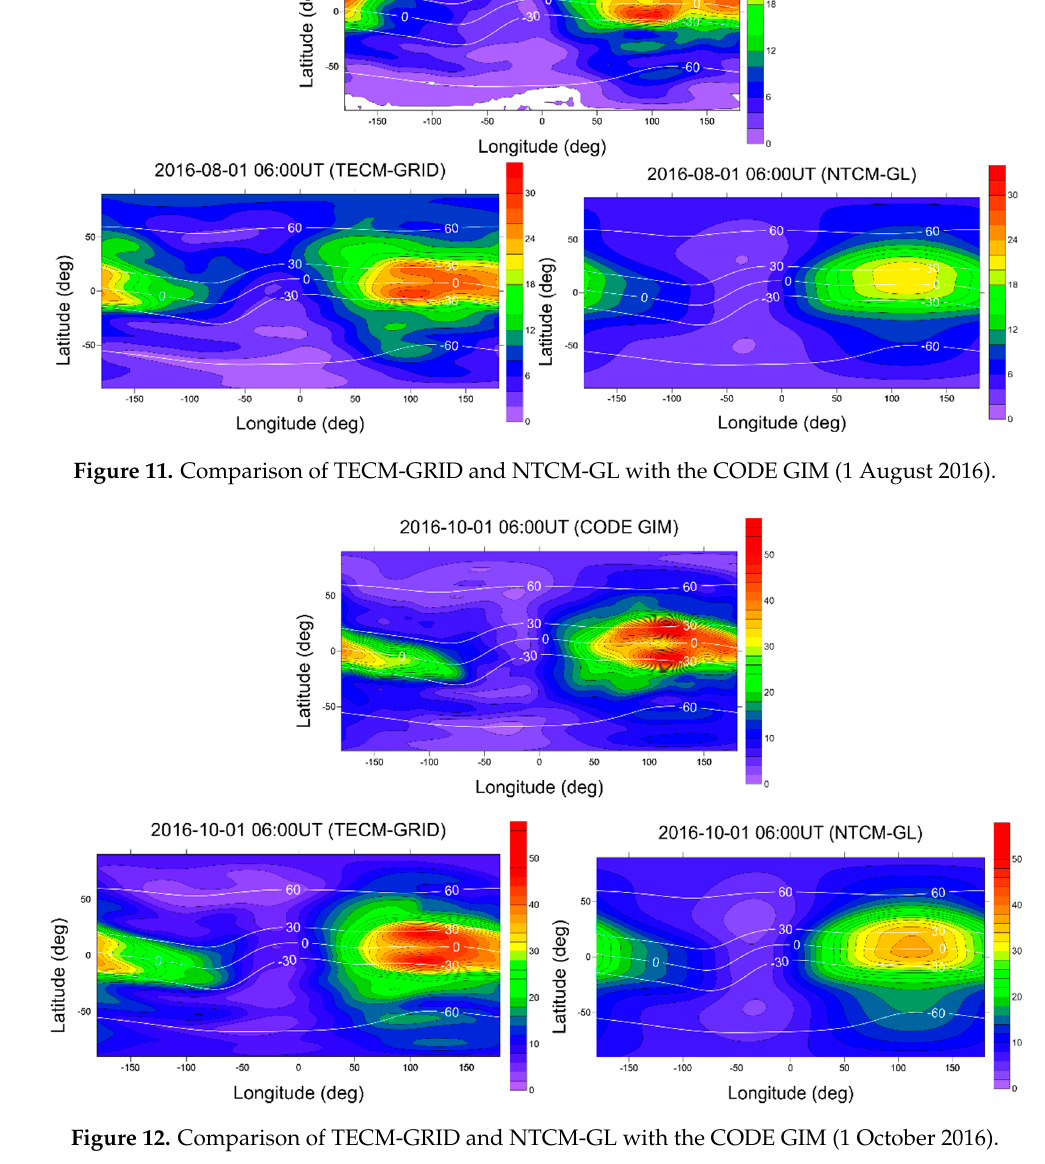
Figure 12. Comparison of TECM-GRID and NTCM-GL with the CODE GIM (1 October 2016).